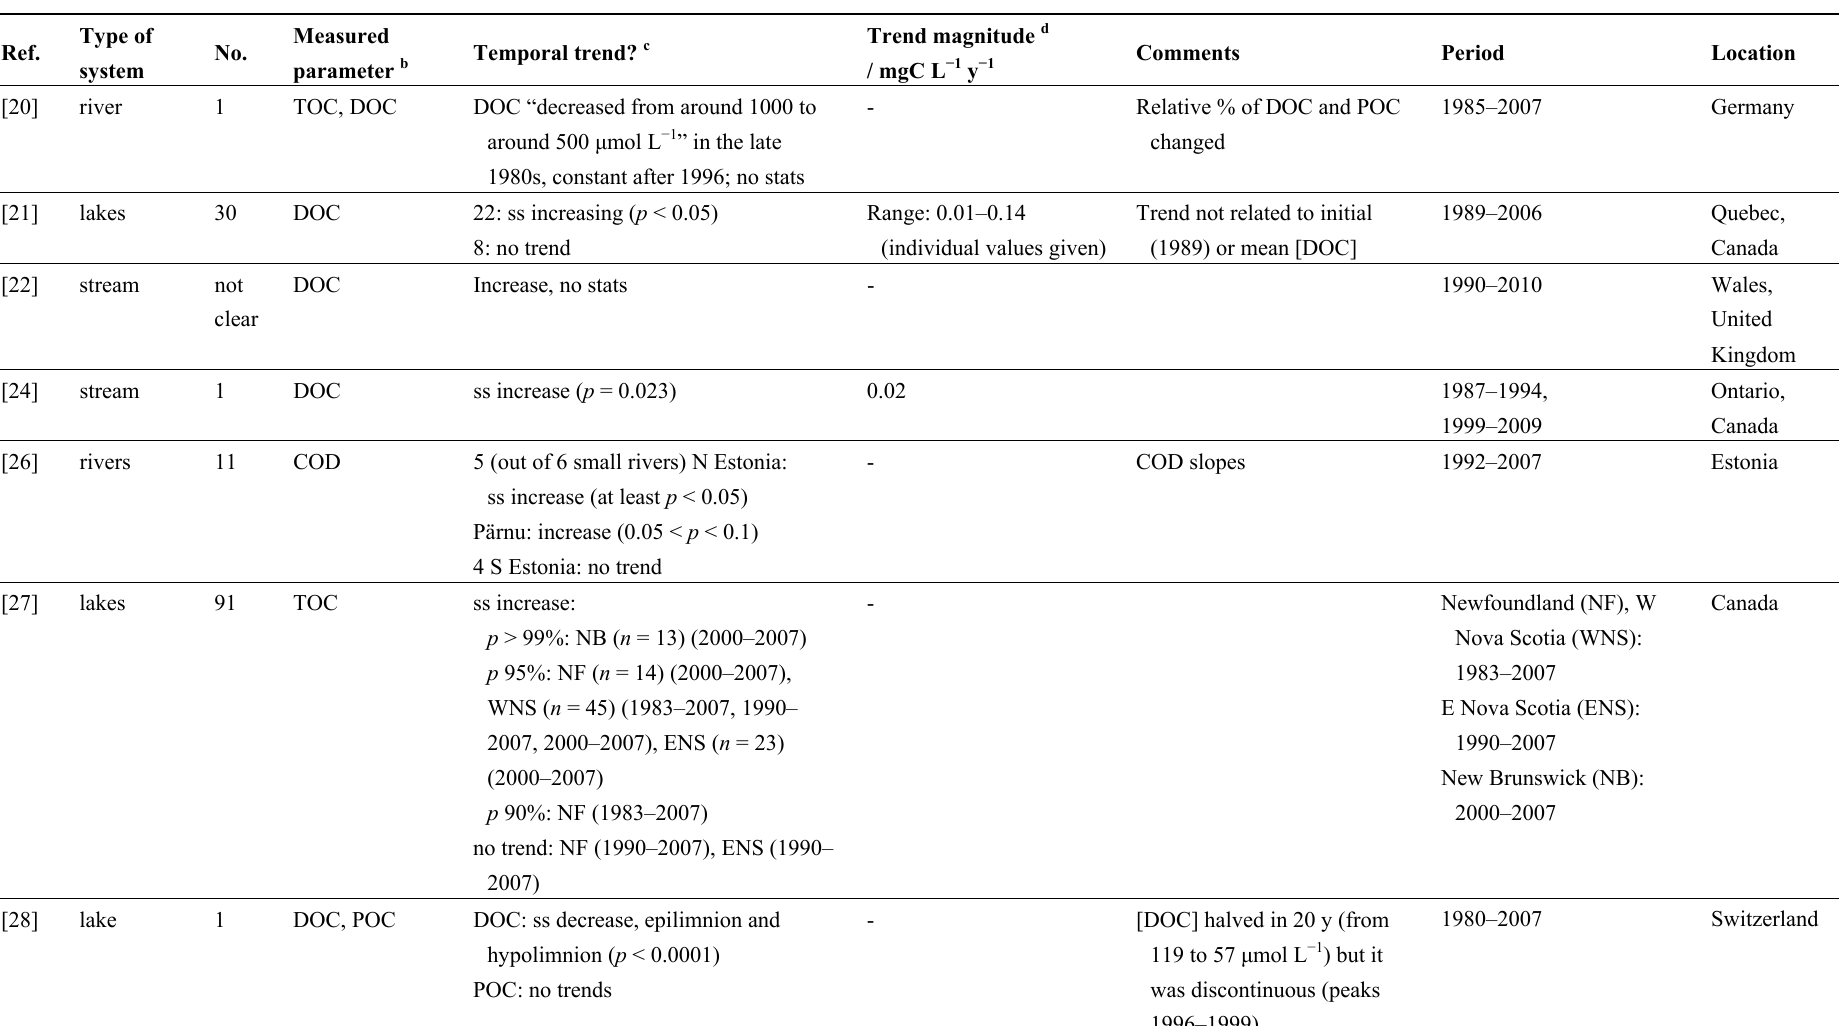
Table 3. Published long-term temporal trends in organic carbon concentrations in freshwaters.